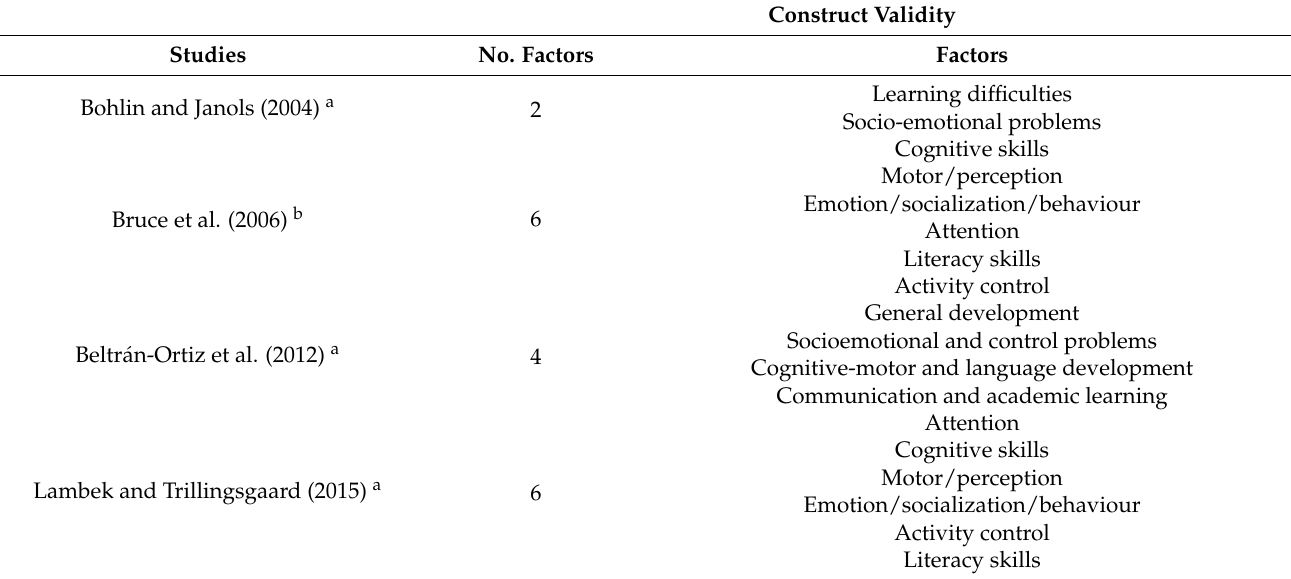
Table 2. Construct Validity of the FTF Questionnaire from European and Chilean